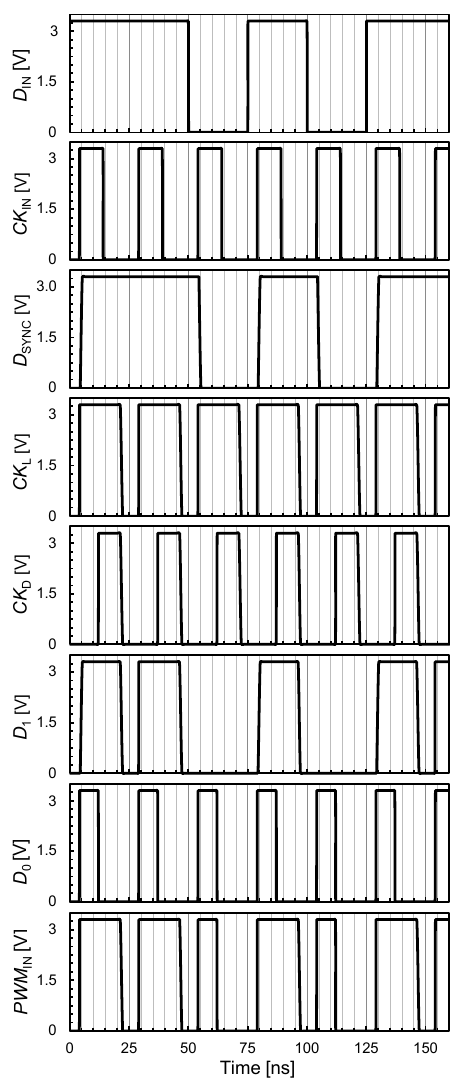
Figure 13. PWM modulator signals for a data rate frequency ( f D ) of 40 Mbit / s and bit sequence “110101”.